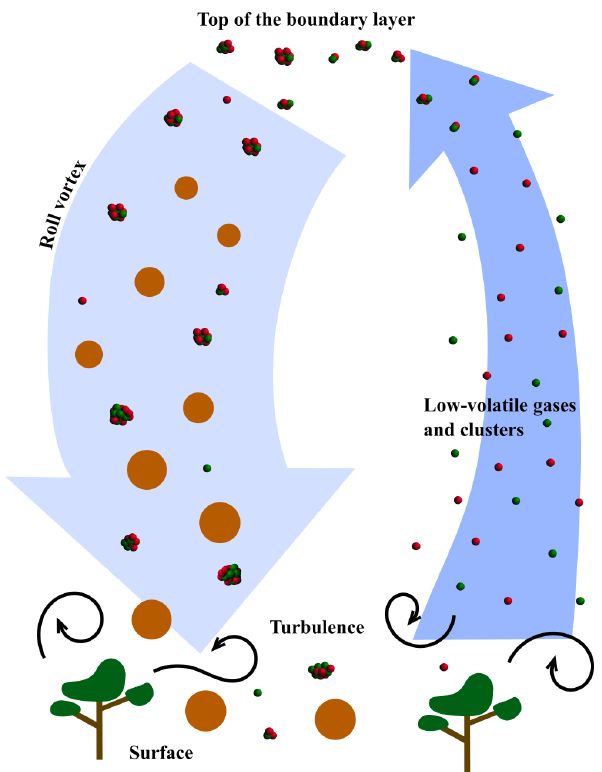
Figure 2. A schematic illustration of roll-induced NPF when viewed along a